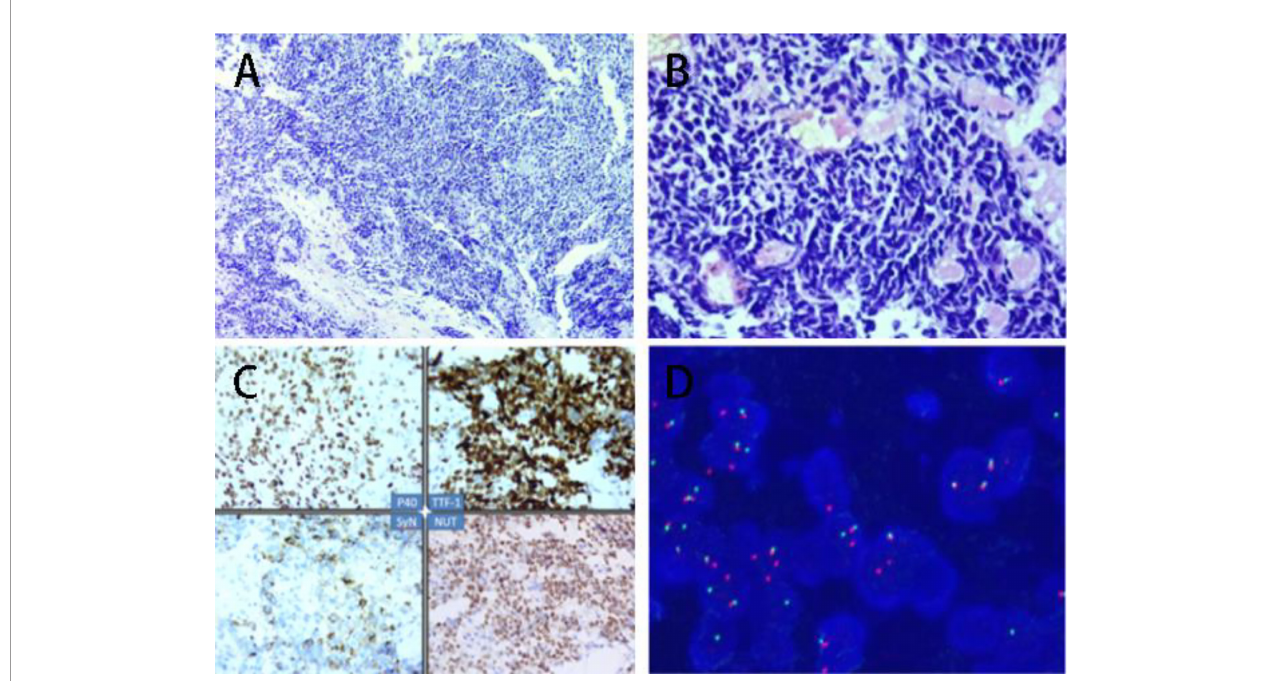
FIGURE 2 | (A) Tumor small-medium size, fi ne nuclear staining, no nucleoli (HE, 10X); (B) Tumor small-medium size, fi ne nuclear staining, no nucleoli (HE, 40X); (C) 1.P40 positive(Immunohistochemical staining); 2. TTF-1 positive (Immunohistochemical staining); 3. SyN positive (Immunohistochemical staining); NUT positive (Immunohistochemical staining); (D) Fluorescence in situ hybridization (FISH) display: 45% of tumor cells show red and green separation signals (DAPI color development,